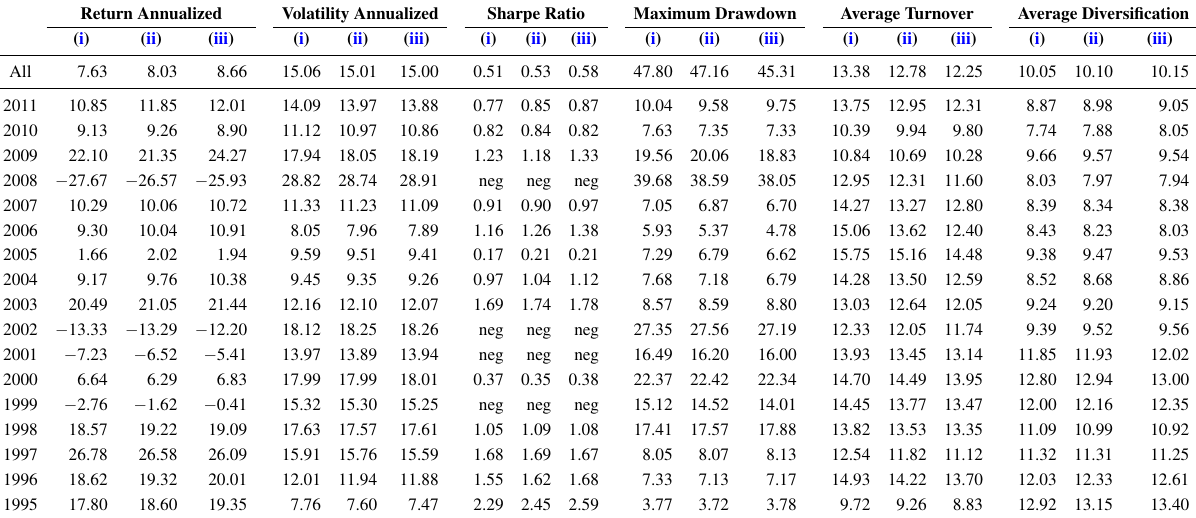
Table 1. Out-of-sample backtesting results of the strategies (i)–(iii). All numbers are expressed in percent except for Sharpe ratios and average degrees of diversification. The return and volatility values are annualized assuming 250 trading days per year.